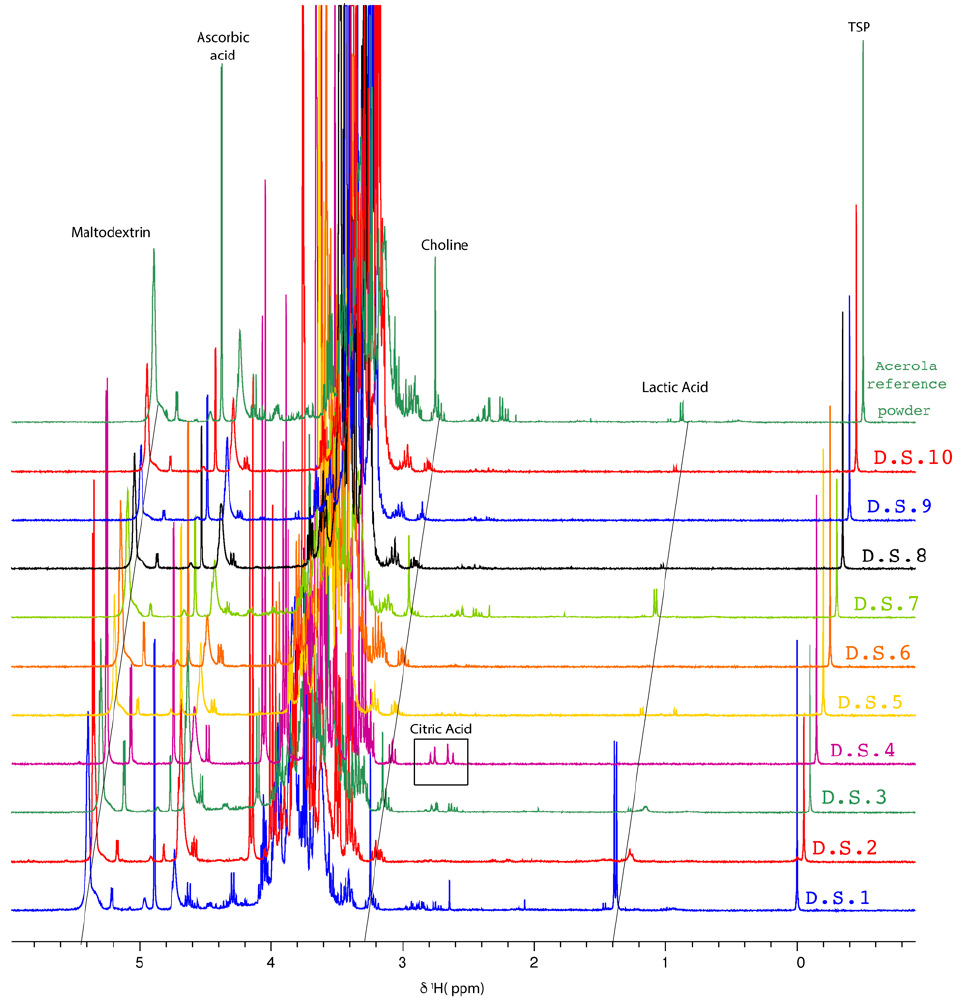
Figure 3. Stacked plot of 1D 1 H-NMR spectra of each food supplement sample (400 MHz, 300 K, D 2 O, pH 3.35, 20 mM TSP).